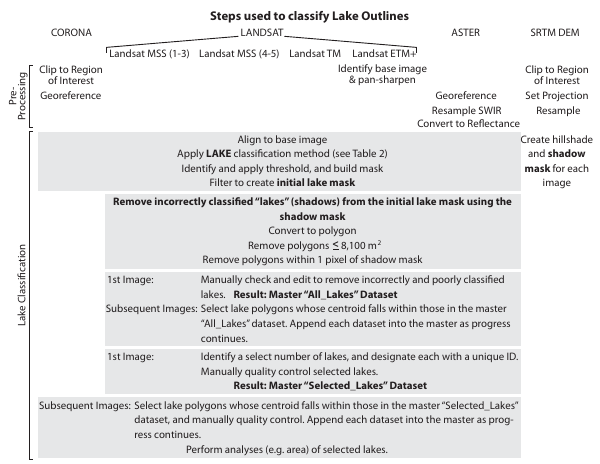
Fig. 4. Steps summarizing the processes used to classify lake out- lines, including pre-processing steps. Grey background overlaps those data sets to which each process applies, and bold text indi- cates important steps or data sets (either complete, or to be used in subsequent